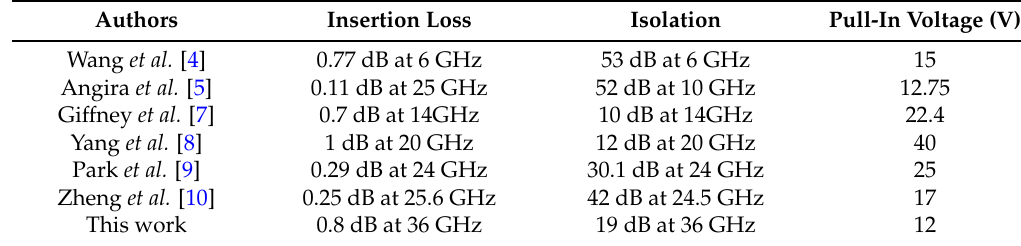
Table 2. Performances of radio frequency (RF) microelectromechanical system (MEMS) switches.